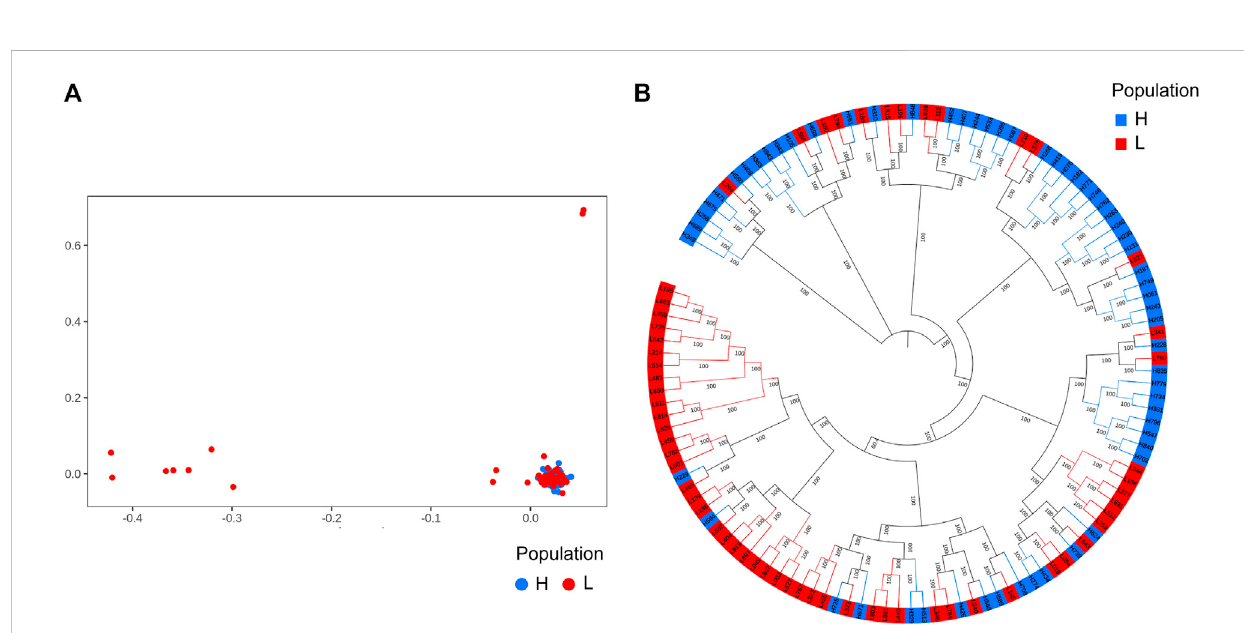
FIGURE 2 Population structure analysis results. A total of 9,735,956 SNPs and 120 donkeys were used to perform the analysis. The 120 donkeys are ranked in descending order of body height, the top 60 donkeys are the larger ones, denoted by H, and the bottom 60 donkeys are the smaller ones, denoted by L. (A) . Principal component analysis results. (B) . Phylogenetic